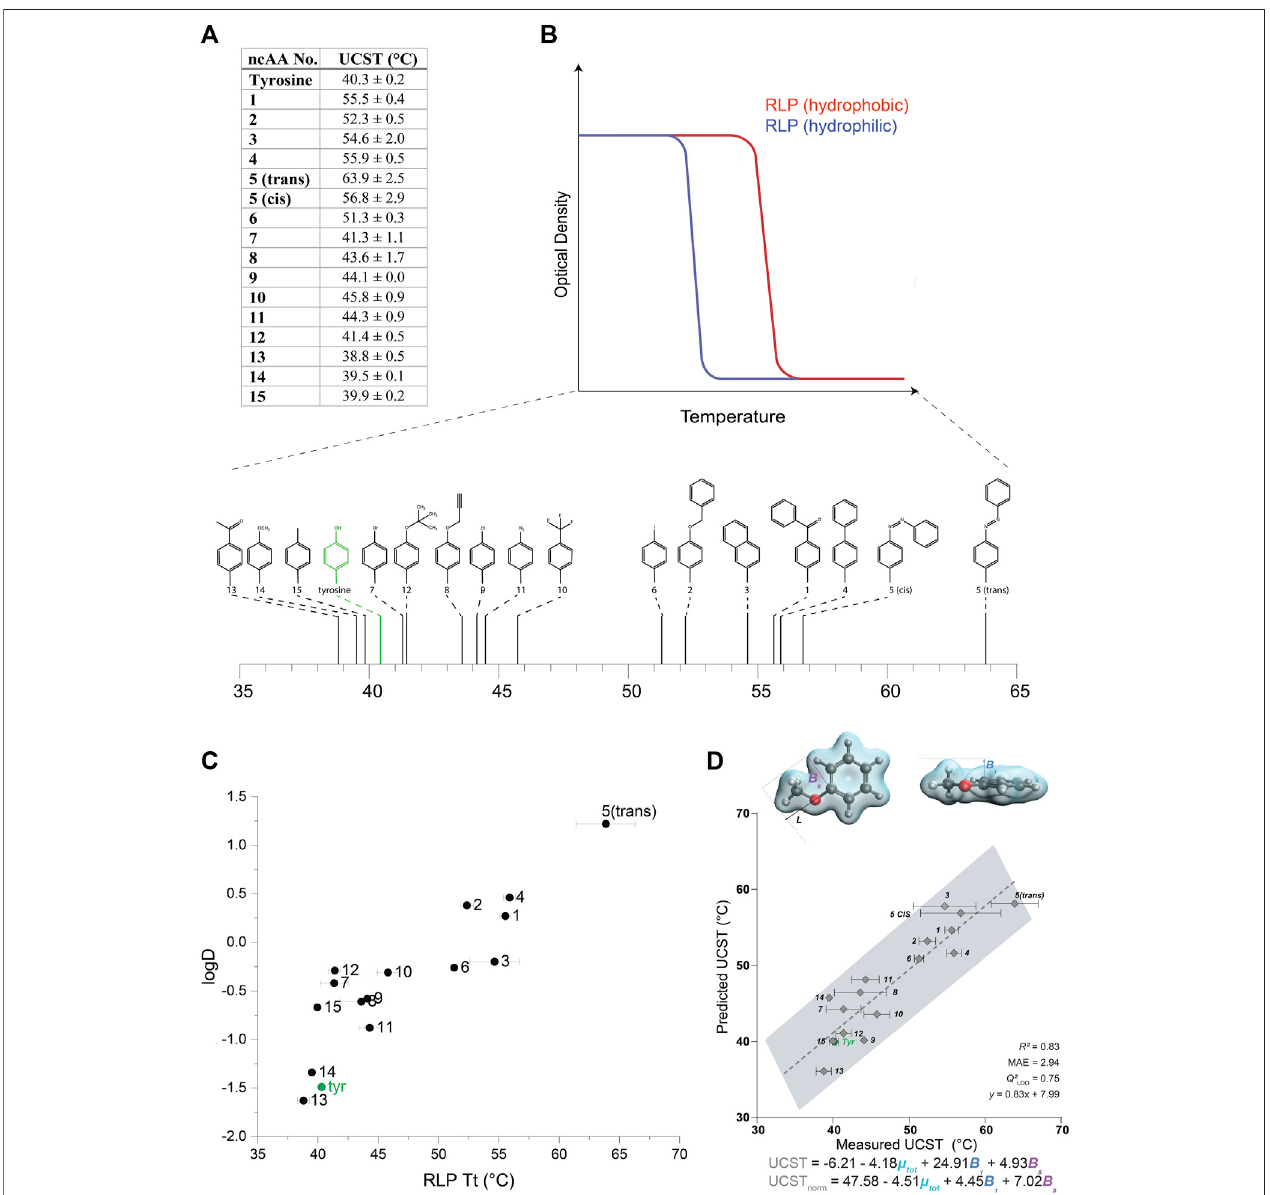
FIGURE3|(A) UCSTvaluescalculatedforRLPscontainingeachofthe15ncAAsdepictedin SupplementaryFigureS1 . (B) Aschematicillustrationoftheeffect of the relative hydrophobicity of the AA or ncAA incorporated in the RLP sequence on its UCST, and a schematic indicating the measured UCST values for the RLPs bearing ncAAs 1 – 15. (C) The relationship between the UCST of RLPs bearing ncAAs 1 – 15, and predicted logD values of the ncAAs. (D) Multivariate linear regression model that includes B 1 , B 5 , and µ -total as predictive molecular descriptors for the aggregation temperature of different RLP analogs. The goodness-of- fi t is indicated by R 2 and Q 2 for a leave-one-one (LOO) cross validation. The equations predicting the transition temperature, UCST and USCT norm , are indicated for raw and normalized parameters (by subtracting the respective mean and dividing by the standard deviation),